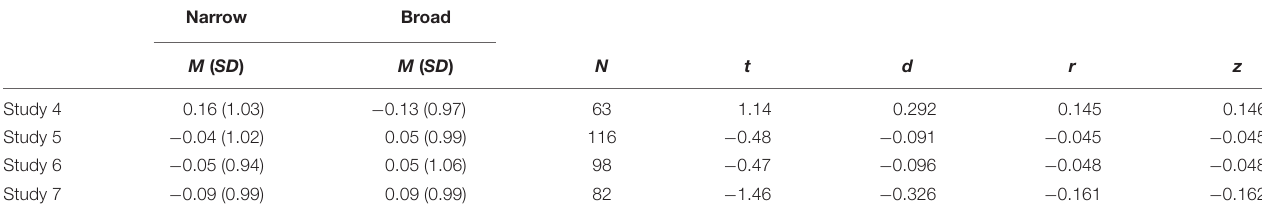
TABLE 12 | Meta-analysis of effect of cognitive scope condition on implicit anger/aggression. Narrow